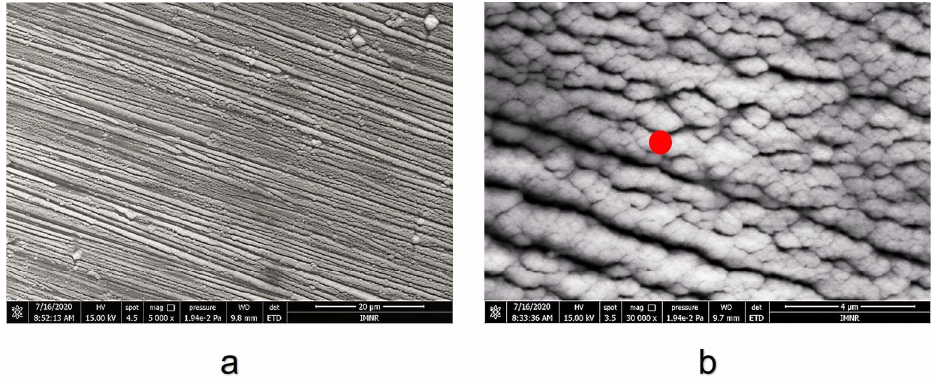
Figure 6. SEM image depicting the surface of the alumina-deposited layer at different magnifica- 5000 × ( a ) and 30,000 × ( b tions: 5000× ( a ) and 30,000× ( b ).